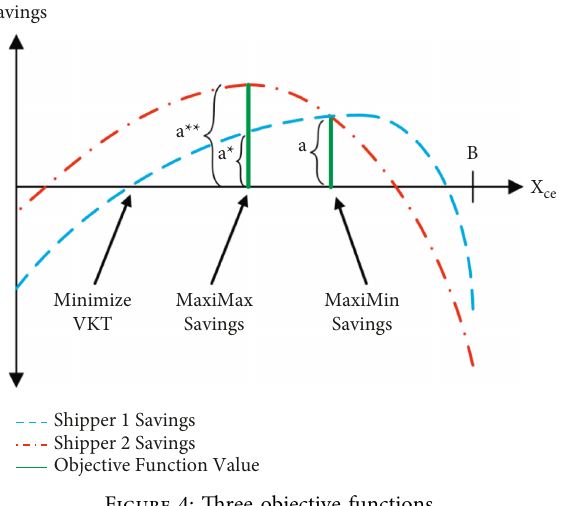
Figure 4: Three objective functions.